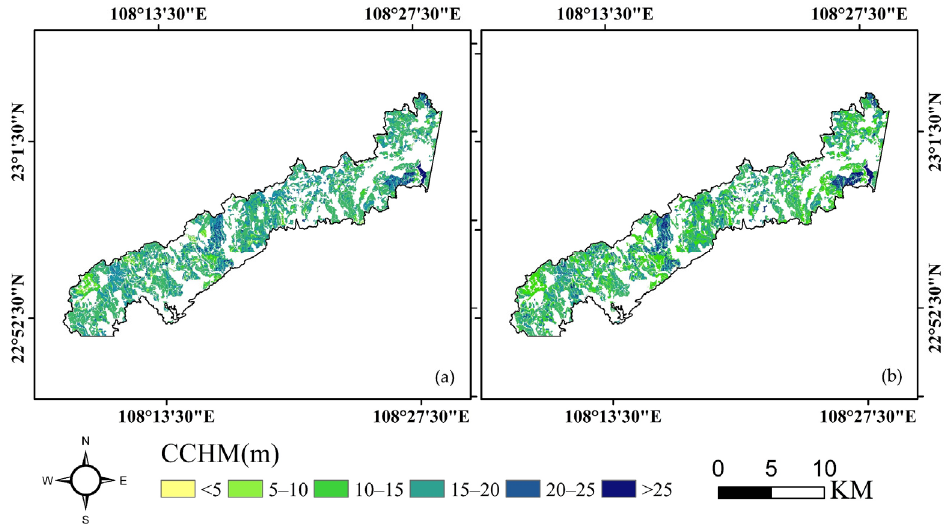
Figure 9. The mapped CCHM of the study area: ( a ) is from single LC8 images and ( b ) is from composite LC8 images.